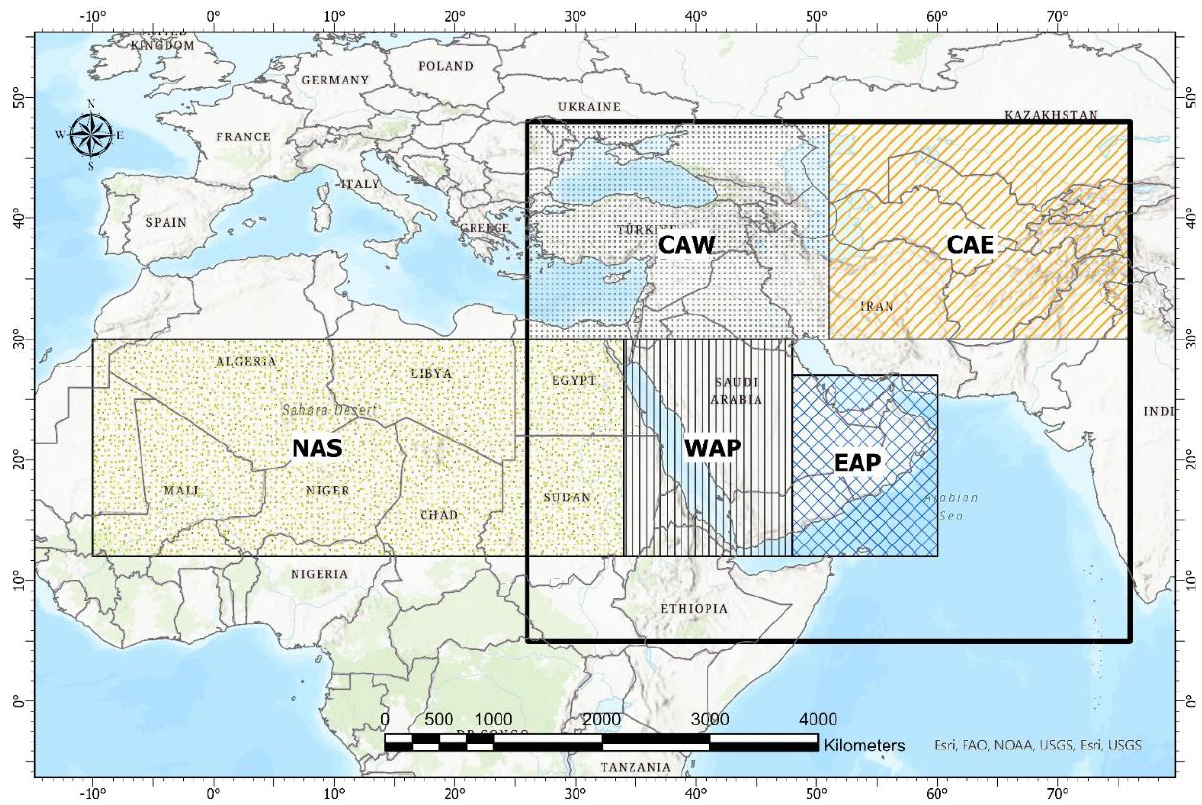
Figure 2. The Key Region (black box) in Huang et al. [23] which has been divided into subregions: Eastern Arabian Peninsula (EAP, 12 – 27° N, 48 – 60° E), Western Arabian Peninsula (WAP, 12 – 32° N, 34 – 48° E), Central Asia West (CAW, 30 – 48° N, 26 – 51° E), and Central Asia East (CAE, 30 – 48° N, 51 – 76° E). North Africa — Sahara (NAS, 12 – 30° N, 10° W – 34° E) is included for comparison.